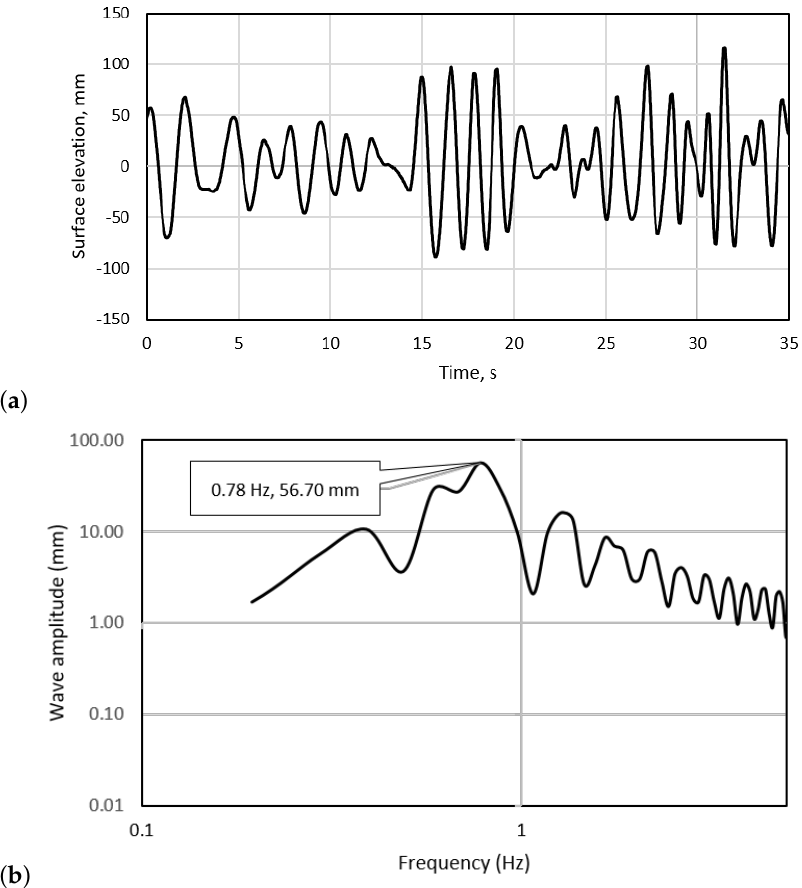
Figure 5. Water surface elevation time series for the irregular wave case undertaken ( a , b ) the frequency spectrum of the